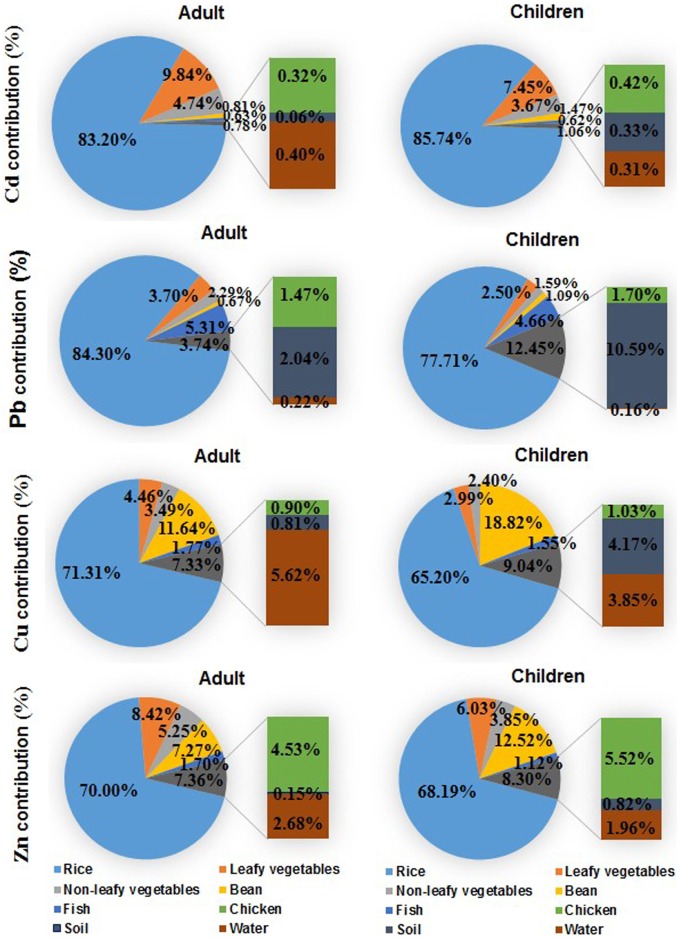
Relative contribution profile of daily human intake.Relative contribution was derived by dividing the daily intake estimate from a given source by the total daily intake estimate from all of the sources under investigation.